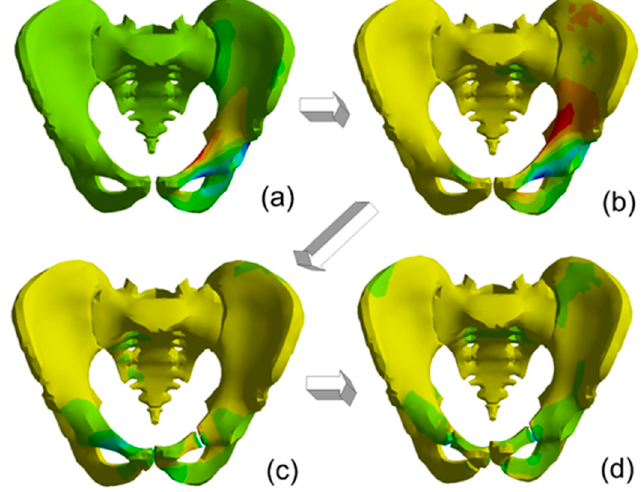
Figure 8. The steps in pelvic fracture for first support case: ( a ) below yield stresses in cortical bone, ( b ) the advantage of compressive forces in left superior pubic ramus, ( c ) Failure of the cortical bone forces in left superior pubic ramus, ( d ) Failure of the cortical bone forces in right superior pubic ramus and the left interior ramus.